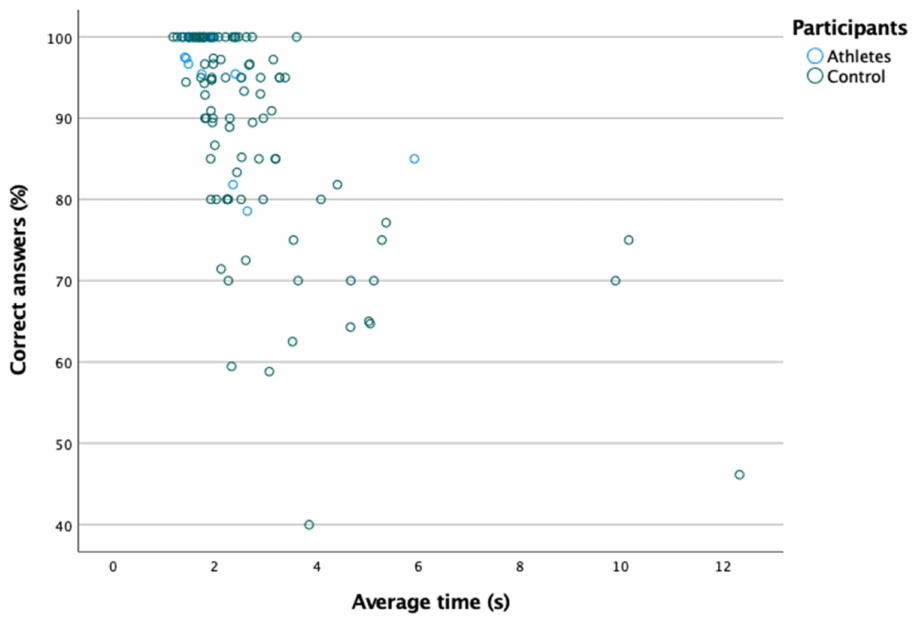
Figure 6. Negative linear relationship between the percentage of correct answers and the average